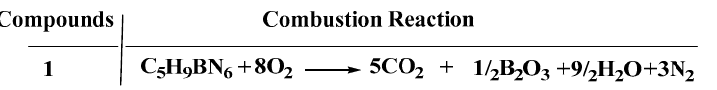
Figure 10. Enthalpy of combustion reaction of the (1-methylimidazolium)(tetrazol-1-yl)borane.